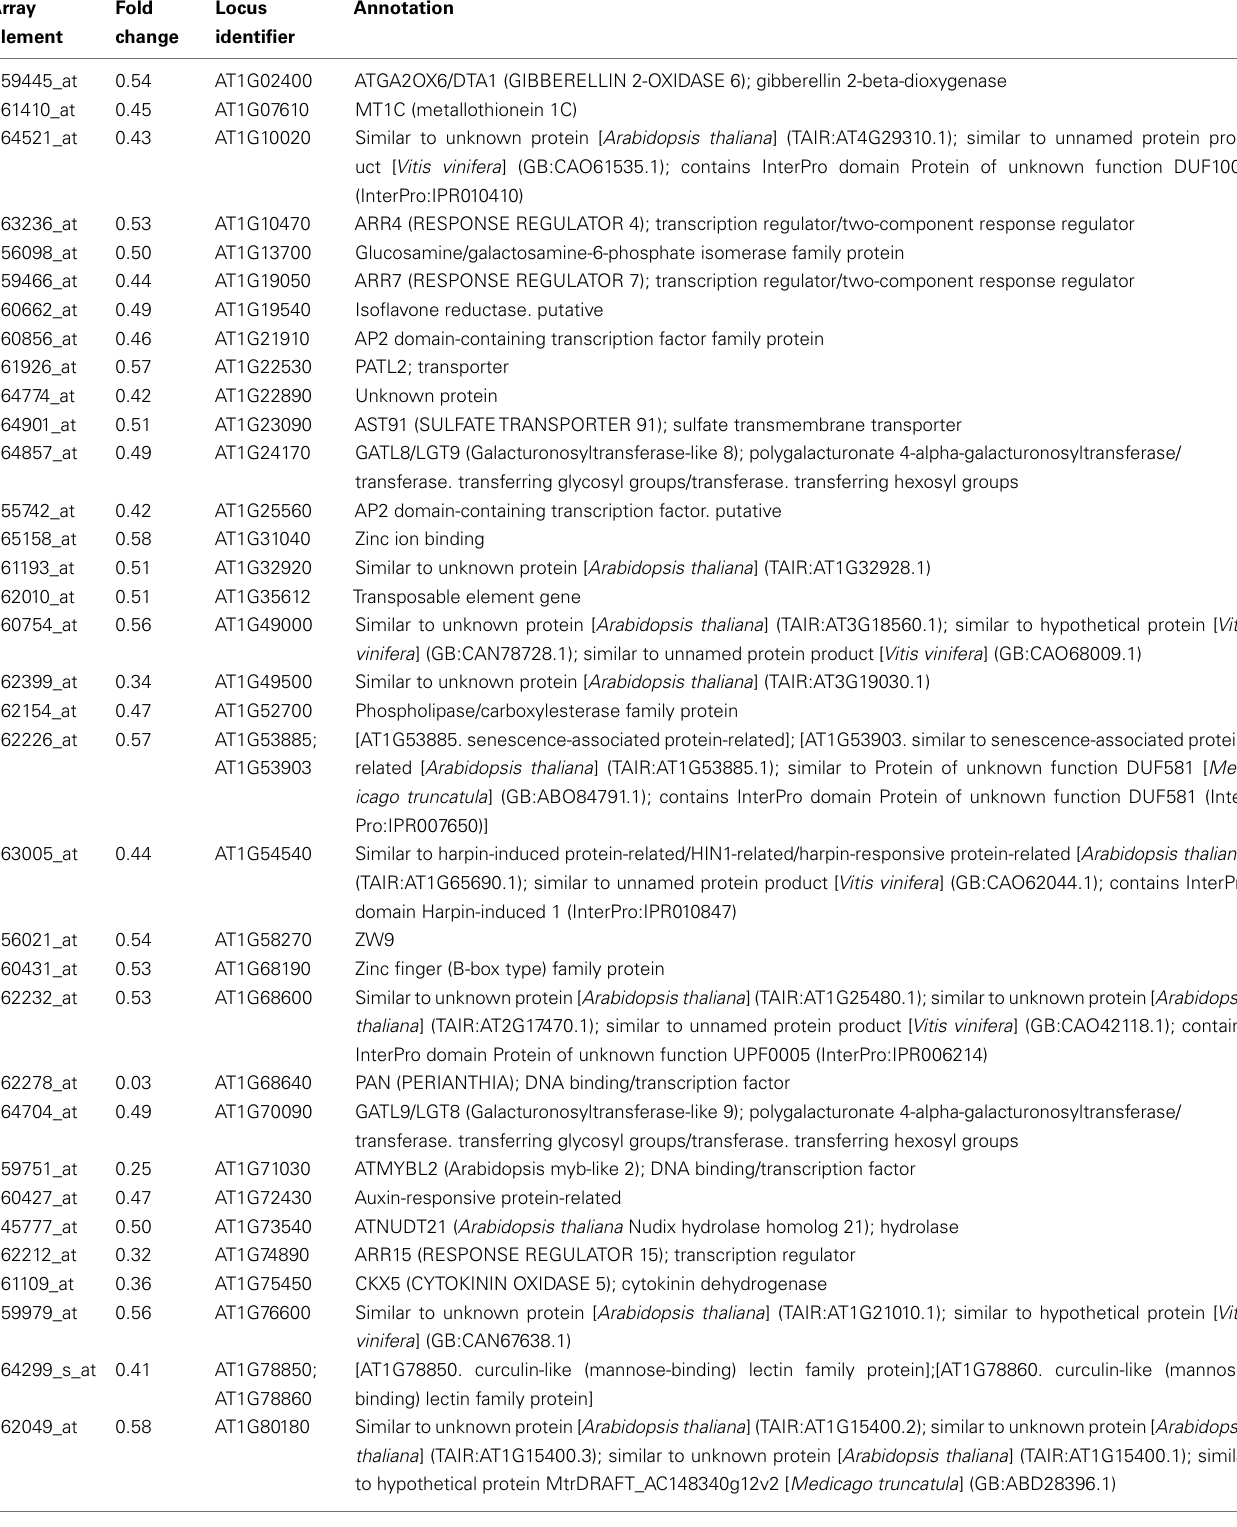
Table 2 | Genes with significantly reduced expression in inflorescence apices of pan mutants (Rank Products FDR 0.05). Array